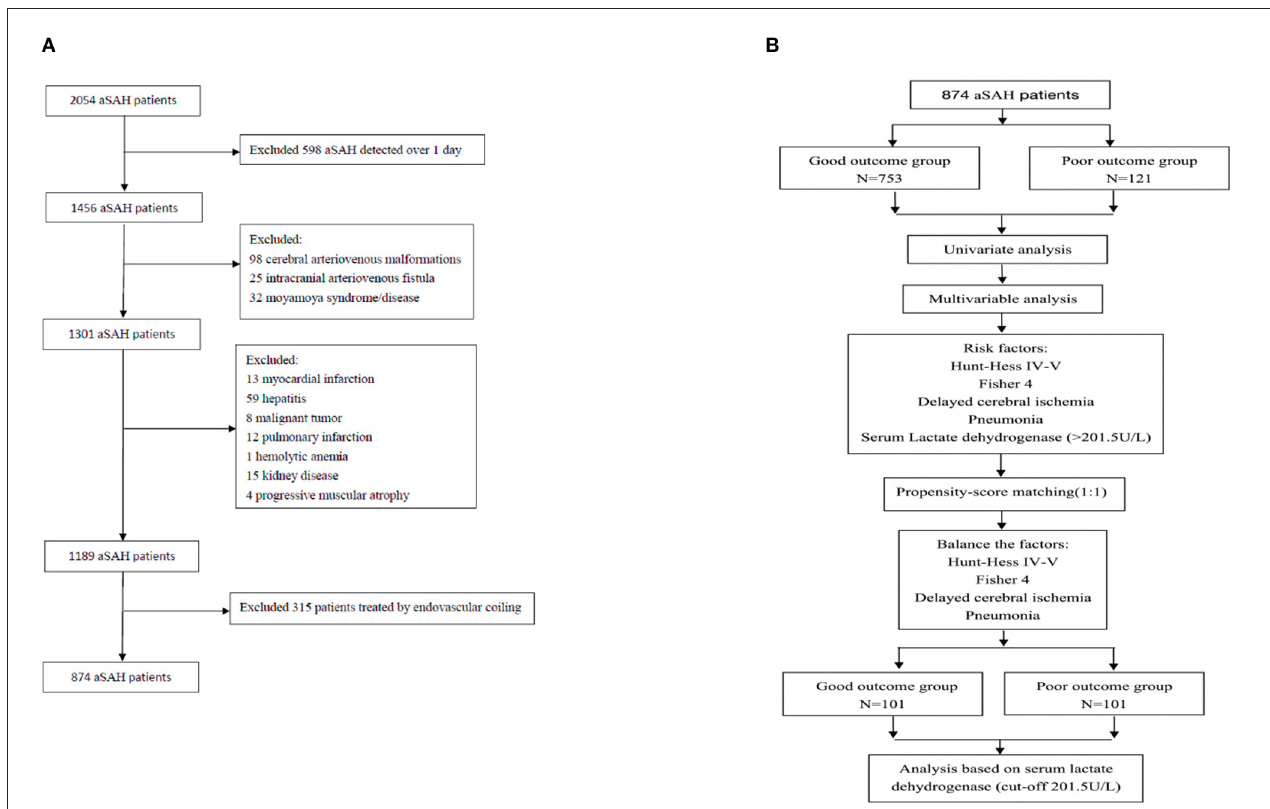
FIGURE 1 | (A) Flowchart of patient inclusion; (B) Flowchart of propensity-score matching.